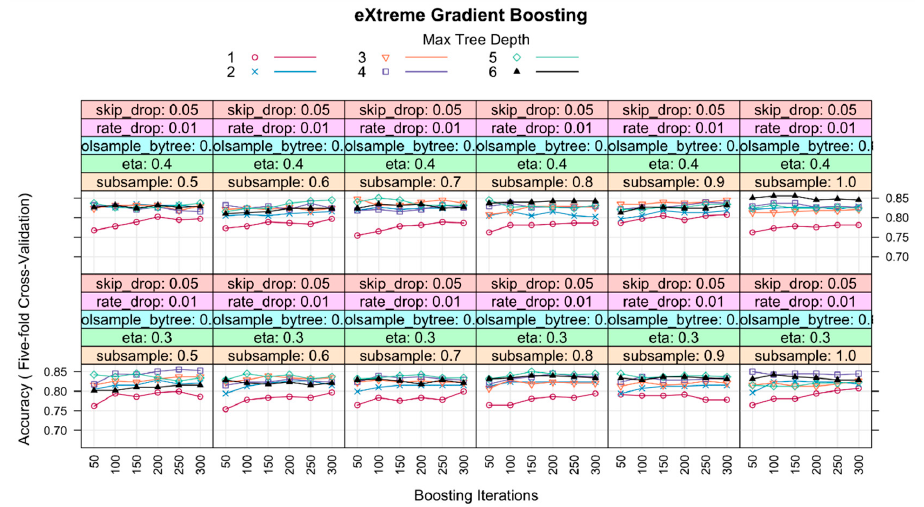
Figure 8. Accuracy variation by tuning parameter profiles (shows partial view) for the eXtreme Gradient Boosting model using the meteorological dataset [2]. The optimal model used the hyperparameters shown in Table 4.